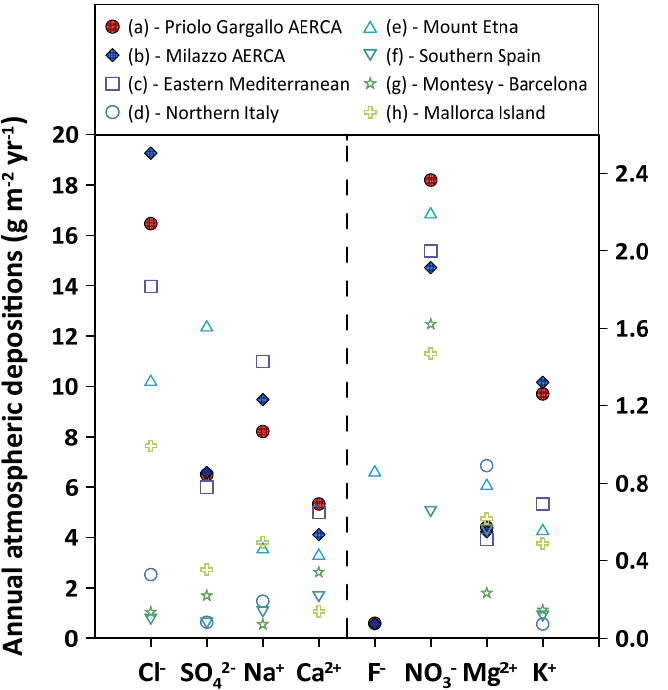
Figure 13. Annual atmospheric depositions (g m − 2 yr − 1 ). (a) this study—Priolo Gargallo AERCA; (b) this study—Milazzo AERCA; (c) Izmir, Turkey (Al-Momani et al. 1995 [53]); (d) northern Italy (Pieri et al. 2010 [64]); (e) Mount Etna (Calabrese et al. 2011 [42]); (f) southern Spain (Morales-Baquero et al. 2013 [65]); (g) Montesy–Barcelona (Castillo et al. 2017 [66]); (h) Mallorca Island (Cerro et al. 2020 [67]). For chloride, sulphate, sodium, and calcium see the axis on the left; for fluoride, nitrate, magnesium, and potassium see the axis on the right.